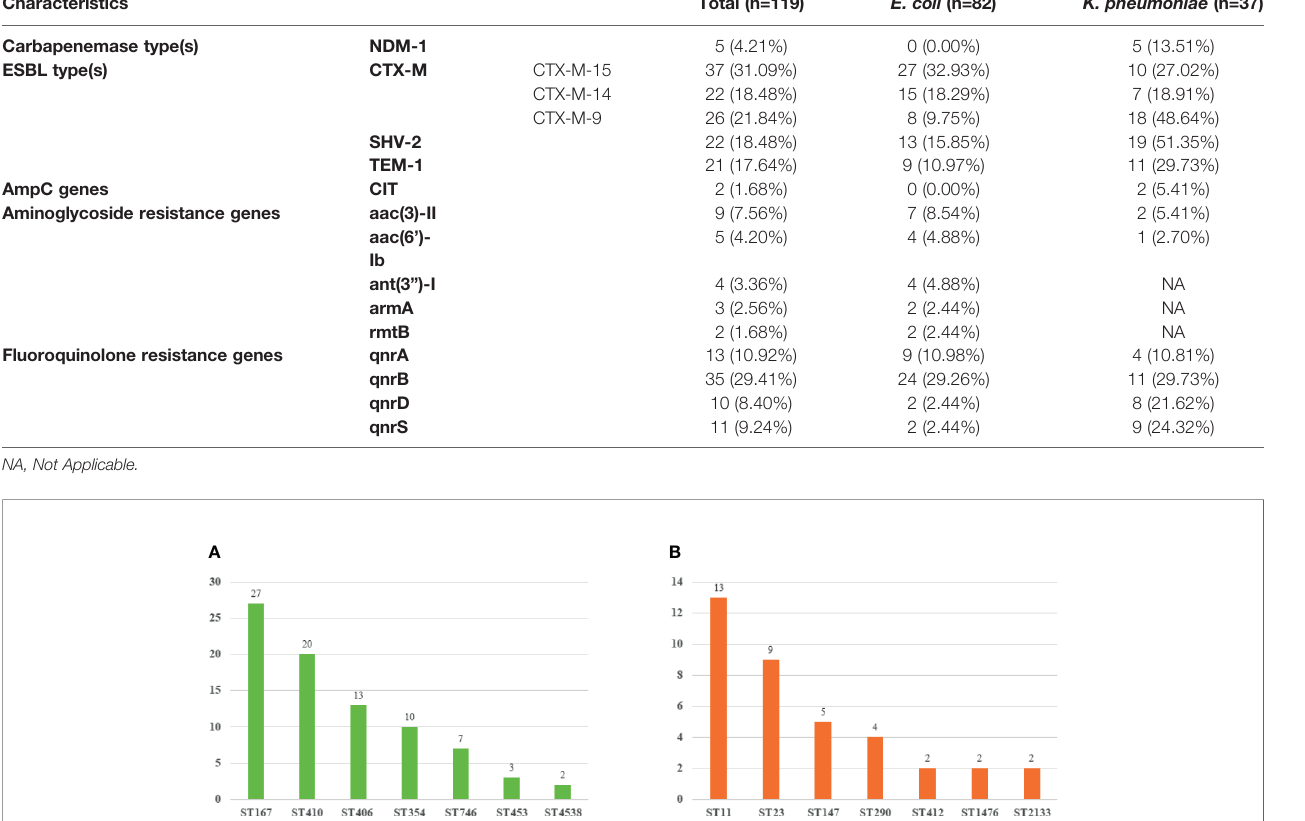
TABLE 4 | Antibiotic resistance genes of E. coli and K. pneumonia